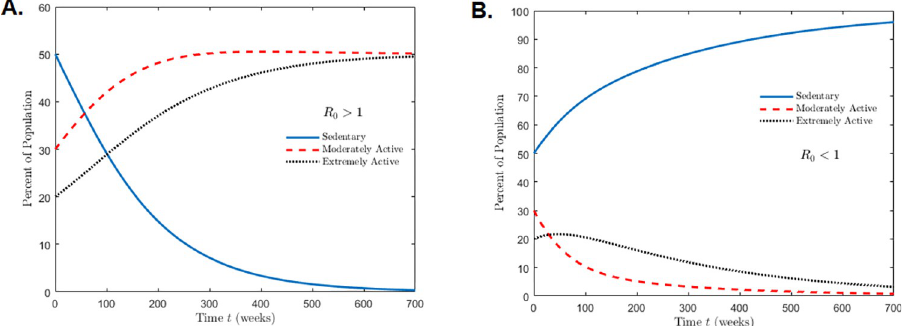
Fig 3. Figure simulates the different outcomes when R 0 > 1 ( A . persistence of exercise) and R 0 < 1 ( B . persistence of sedentary behavior). Initial conditions in both simulations were set as 50% of the population sedentary, 30% moderately active and 20% extremely active. In both simulations, no interactions occur between sedentary and extremely active individuals ( k 2 = r 2 = β 2 = 0). For both A and B , the social interaction parameters that draw sedentary individuals to exercise were set as k 1 = 0.002, r 1 = 0.015 while interactions between active compartments are set to α 1 = α 2 = 0.005. Interactions between sedentary and moderately active individuals that lead to a decrease in physical activity is set to β 1 = 0.0022. In B , the social parameter that draws moderately active individuals to the sedentary population was increased to β 1 =